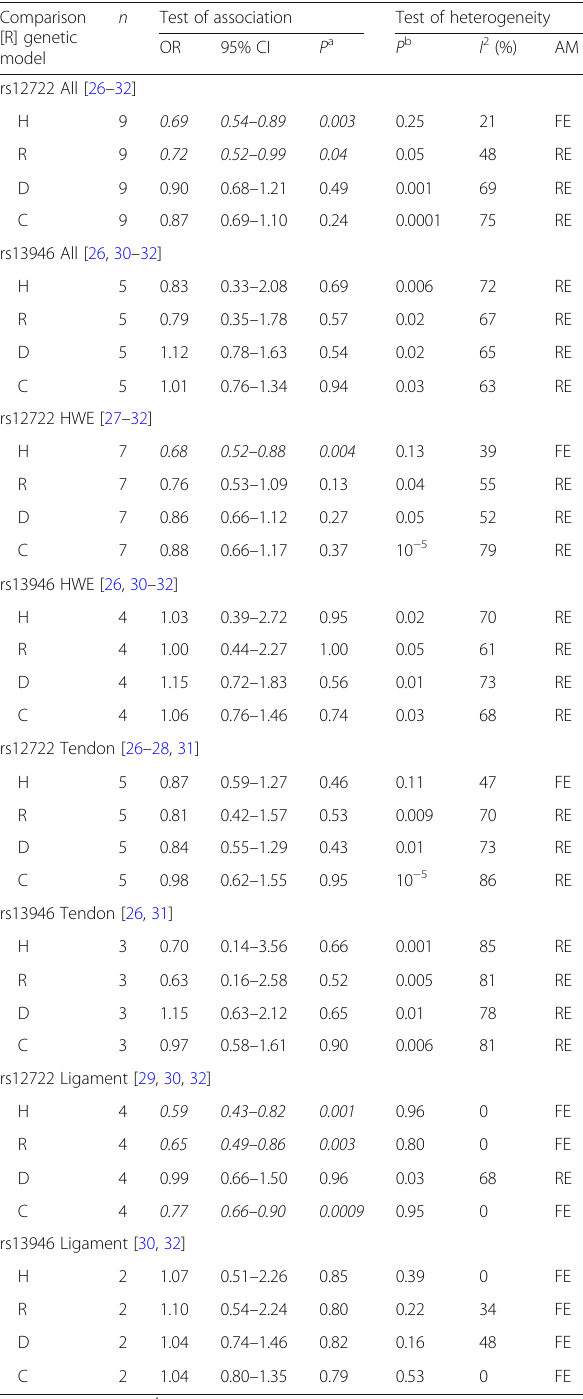
Table 2 Summary effects in the overall, modifier (HWE), and subgroup (tendon/ligament) analyses of COL5A1 with TLI Comparison [R]